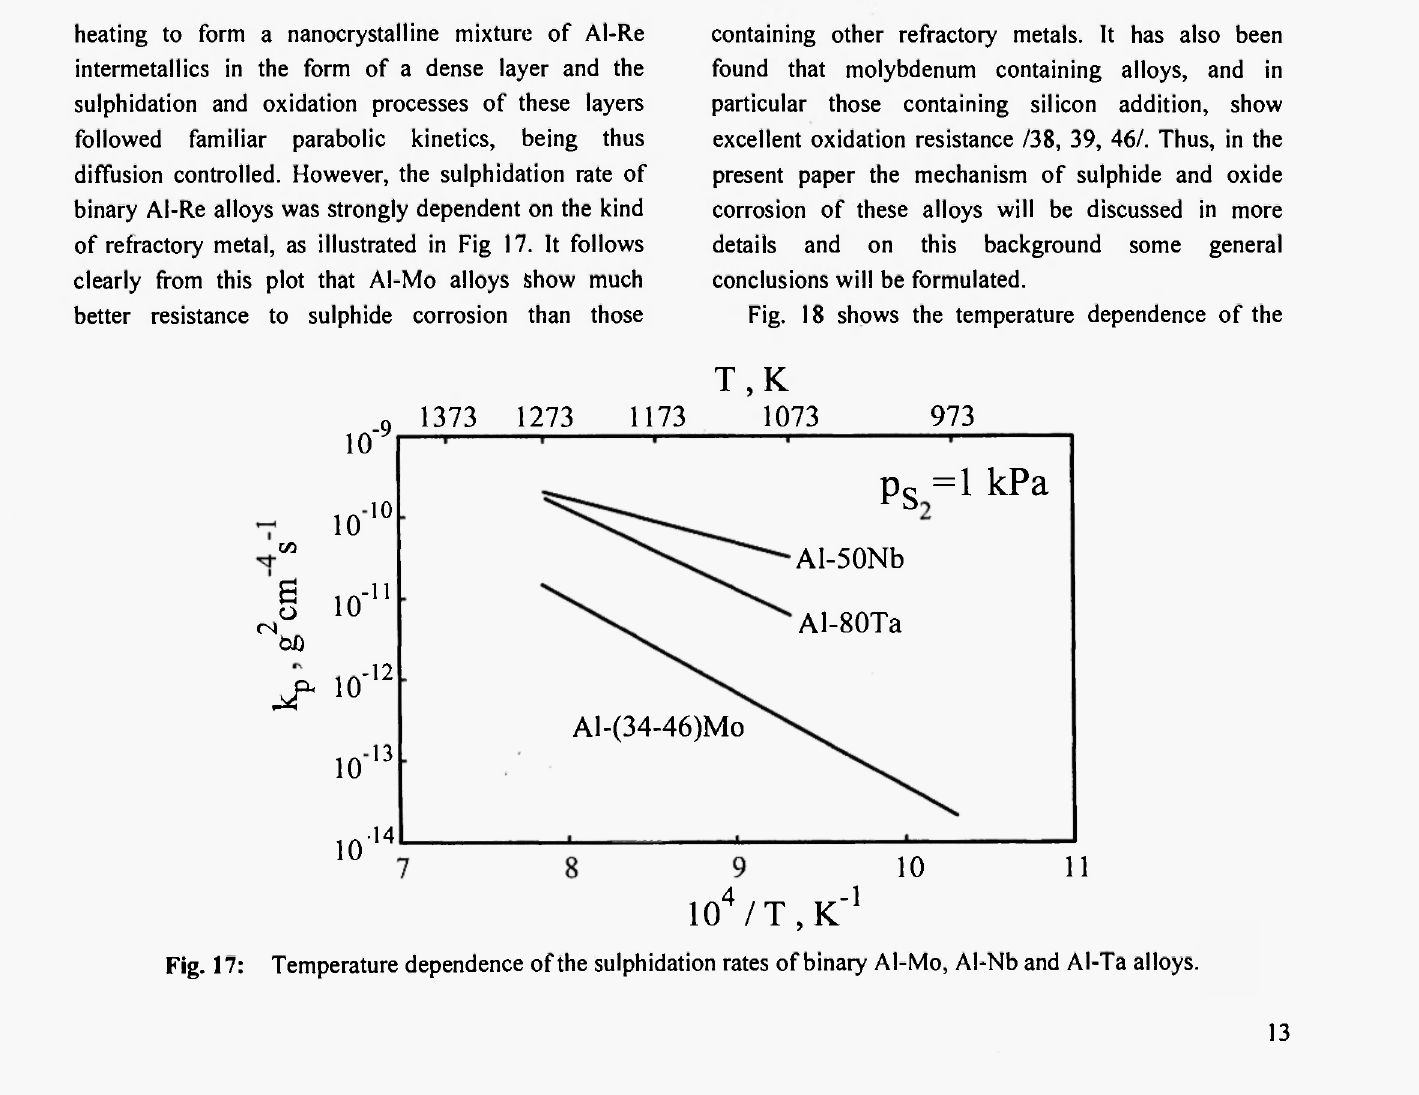
Fig. 16: Structure of sputter-deposited aluminum alloys identified by X-ray diffraction /42/.